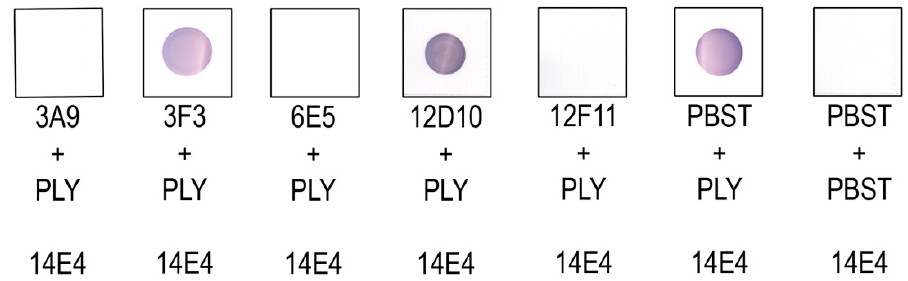
Figure 6. Inhibition of PLY binding to the immobilised cholesterol (1 µM/spot) by the neutralising MAbs 3A9, 3F3, 6E5, 12D10, 12F11 performed by the cholesterol dot blot assay.